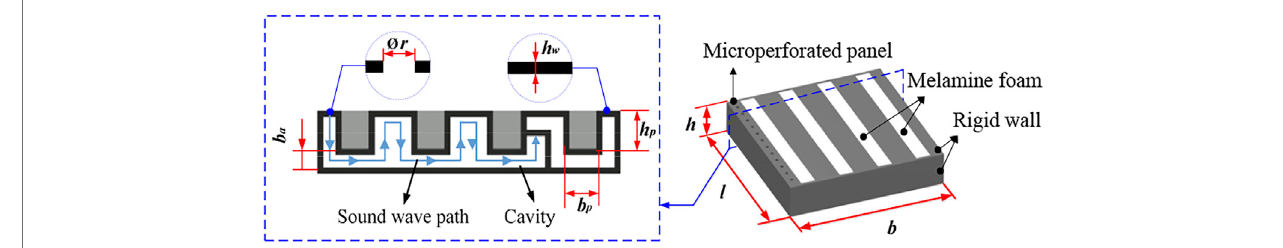
FIGURE 1 | Structure of acoustic liner and its subunit.